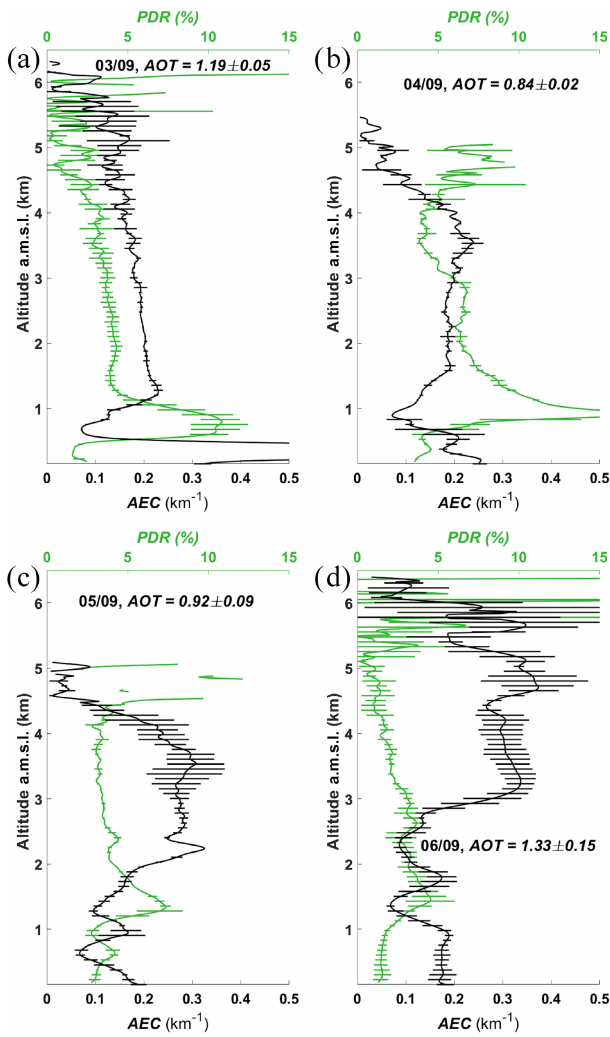
Figure 6. Vertical profiles of the AEC and PDR at 355nm with their uncertainties (horizontal bars) for period P 3 on (a) 3 (14:00– 15:40UTC), (b) 4 (23:30–24:00UTC), (c) 5 (14:00–15:00UTC) and (d) 6 (08:30–10:30UTC) September 2017. The total AOT at 355nm is also given for each profile with its uncertainty.